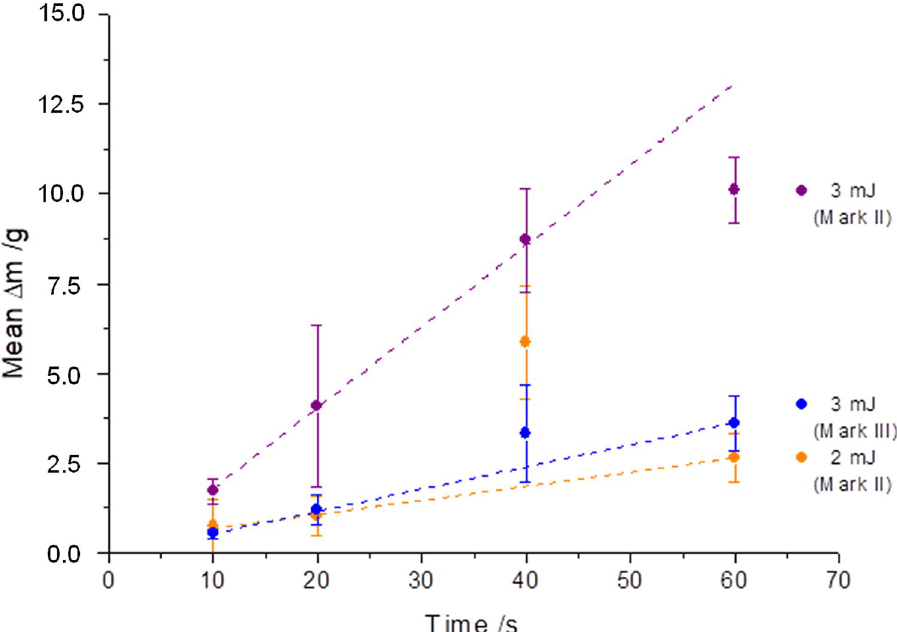
Figure 7. Mark II and Mark III handpieces at pulse energies of 2 mJ and 3 mJ at 6000 cuts/min (100 Hz) for all measurements. Comparable results were achieved for Mark II at 2 mJ and Mark III at 3 mJ.